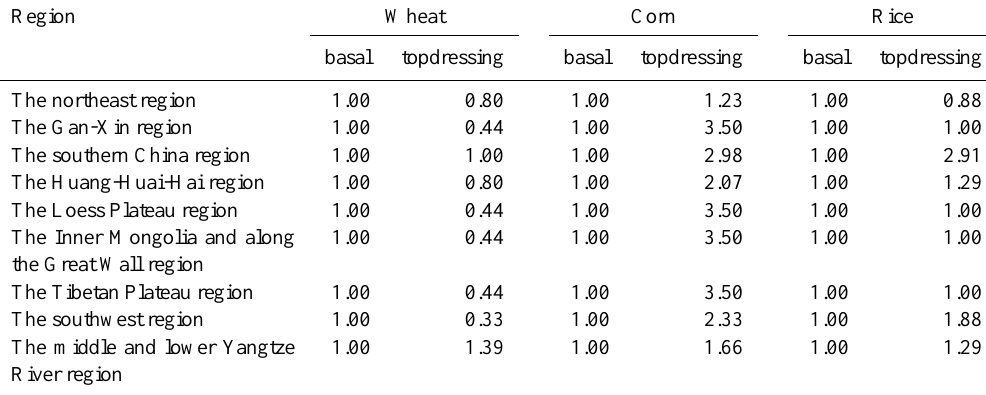
The Huang-Huai-Hai